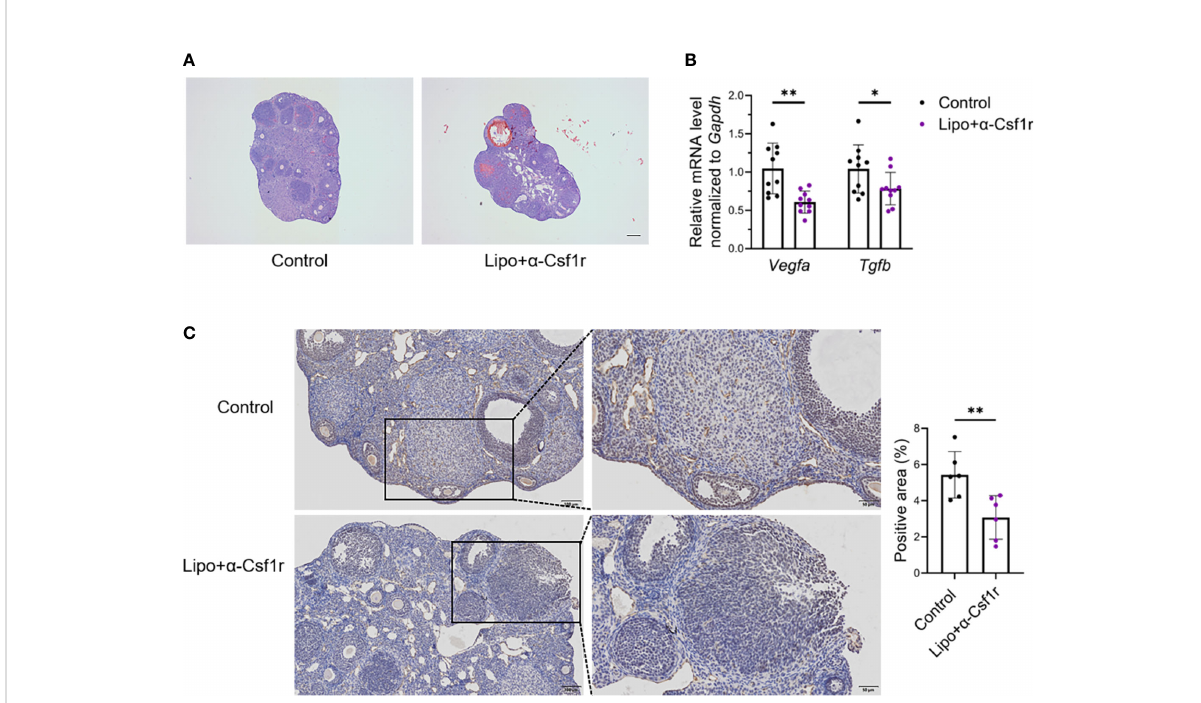
FIGURE 5 Macrophage depletion suppresses angiogenesis and induces ovarian hemorrhage. (A) Hematoxylin-eosin (HE) staining of lipo+ a CSF1r treated mice and control mice ovaries. Scale bar 200 m m. (B) Vegfa and Tgfb expression in the ovaries of lipo+ a CSF1r treated mice and control mice (n=10. Mean ± SEM). (C) Immunohistochemistry and quanti fi cation of anti-CD31 in the ovaries of lipo+ a CSF1 treated mice and control mice (n=6. Mean ± SEM). Scale bar 100 m m or 50 m m. *P < 0.05, **P <